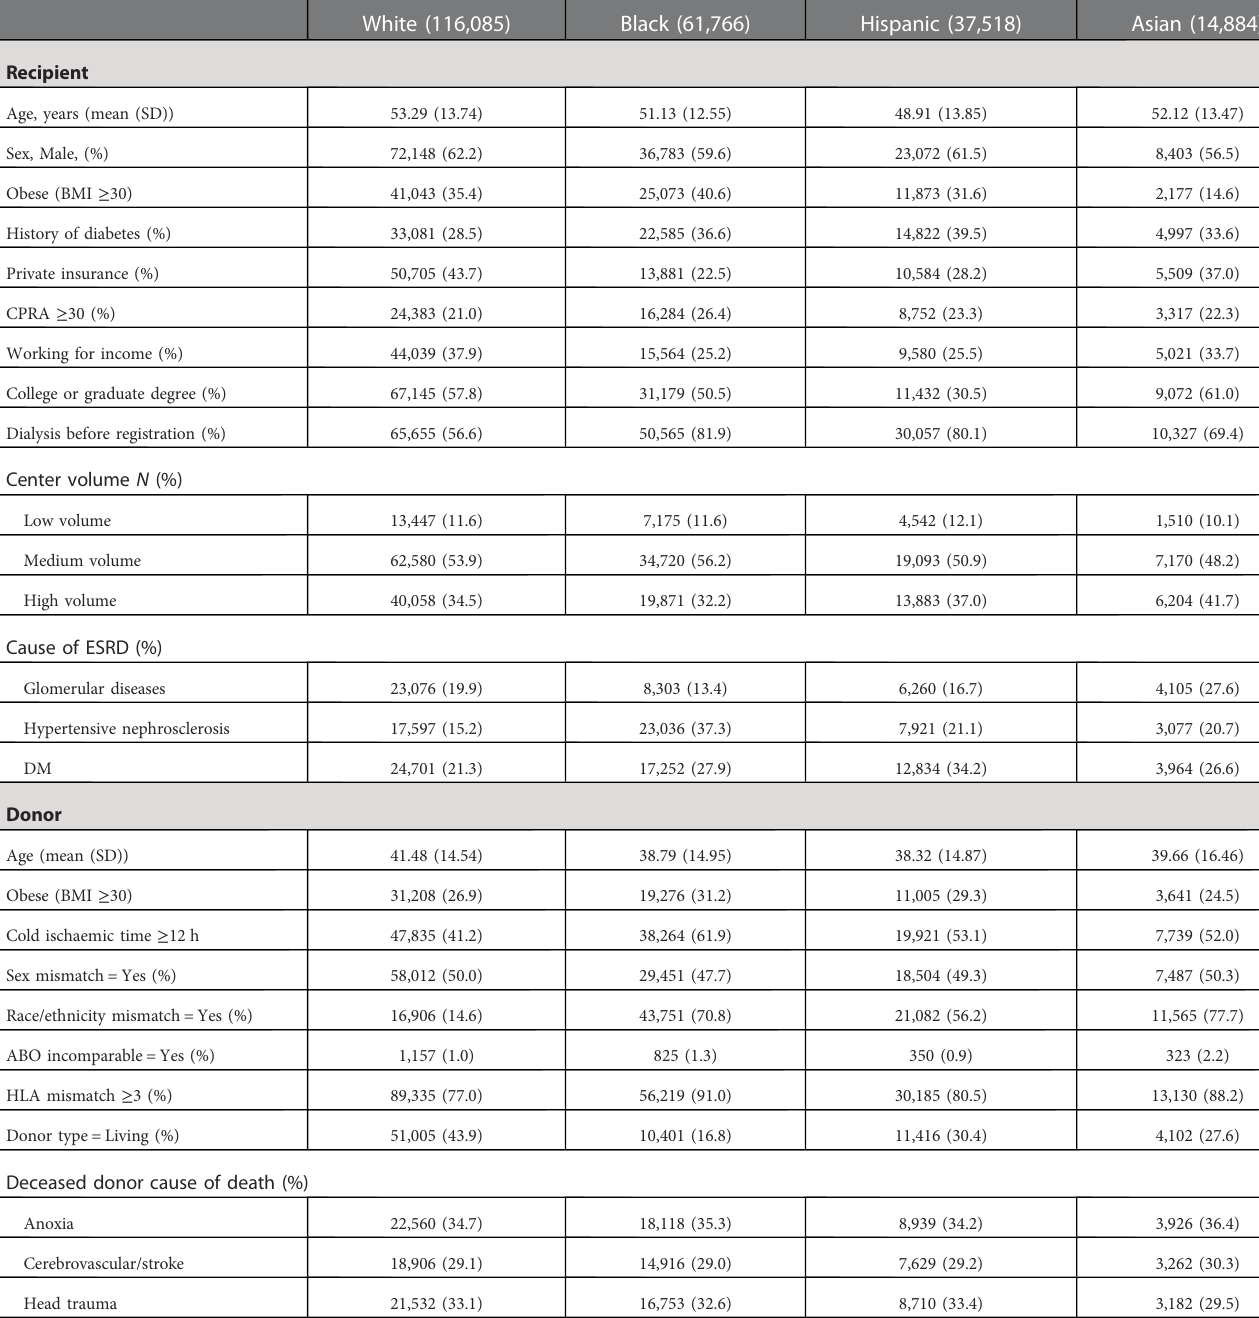
TABLE 2 Clinical characteristics at time of transplantation in kidney transplant recipients and donors, by